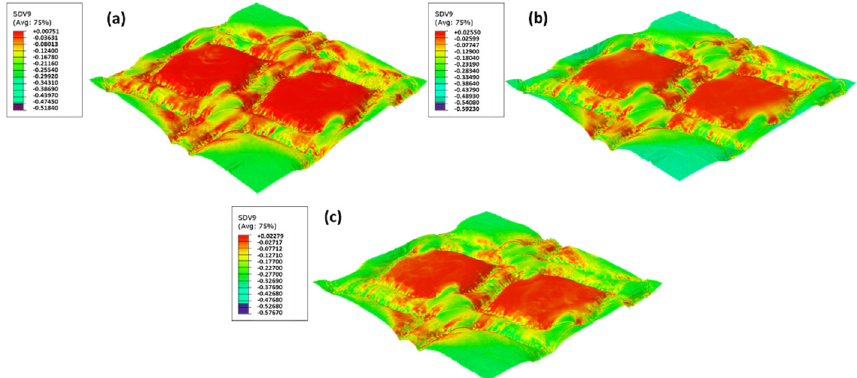
Figure 11. The yield function for deco die for different pressures: ( a ) 2.4 bar, ( b ) 2.8 bar, and ( c ) 3.2 bar. For the microdie, the differences in yielding are presented in Figure 12.